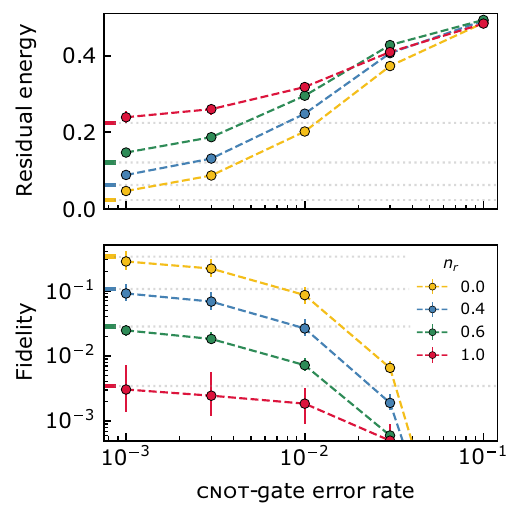
FIG. 7. The QAOA performance as a function of the CNOT - gate error rate for various relative amounts of explicitly enforced constraints n r . The median residual energy and fidelity are aver- aged over 96 problem instances of complete graphs with N = 6 nodes, corresponding to K = 15 physical qubits. The colored markers on the y axis indicate the median residual energy (top panel) and median fidelity (bottom panel) for the noiseless case. The error bars represent the 25th and 75th percentile over the problem